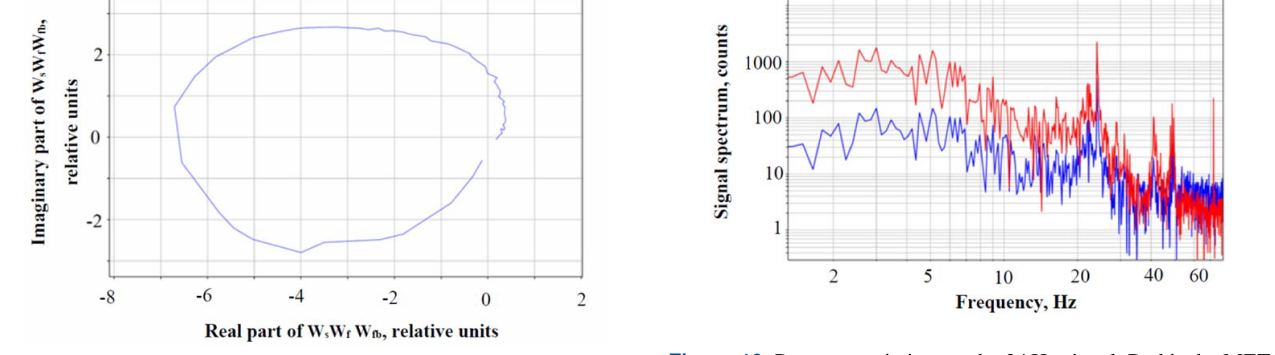
Figure 9. METH W s W f W fb amplitude–phase–frequency response (hodograph) in the complex plane.